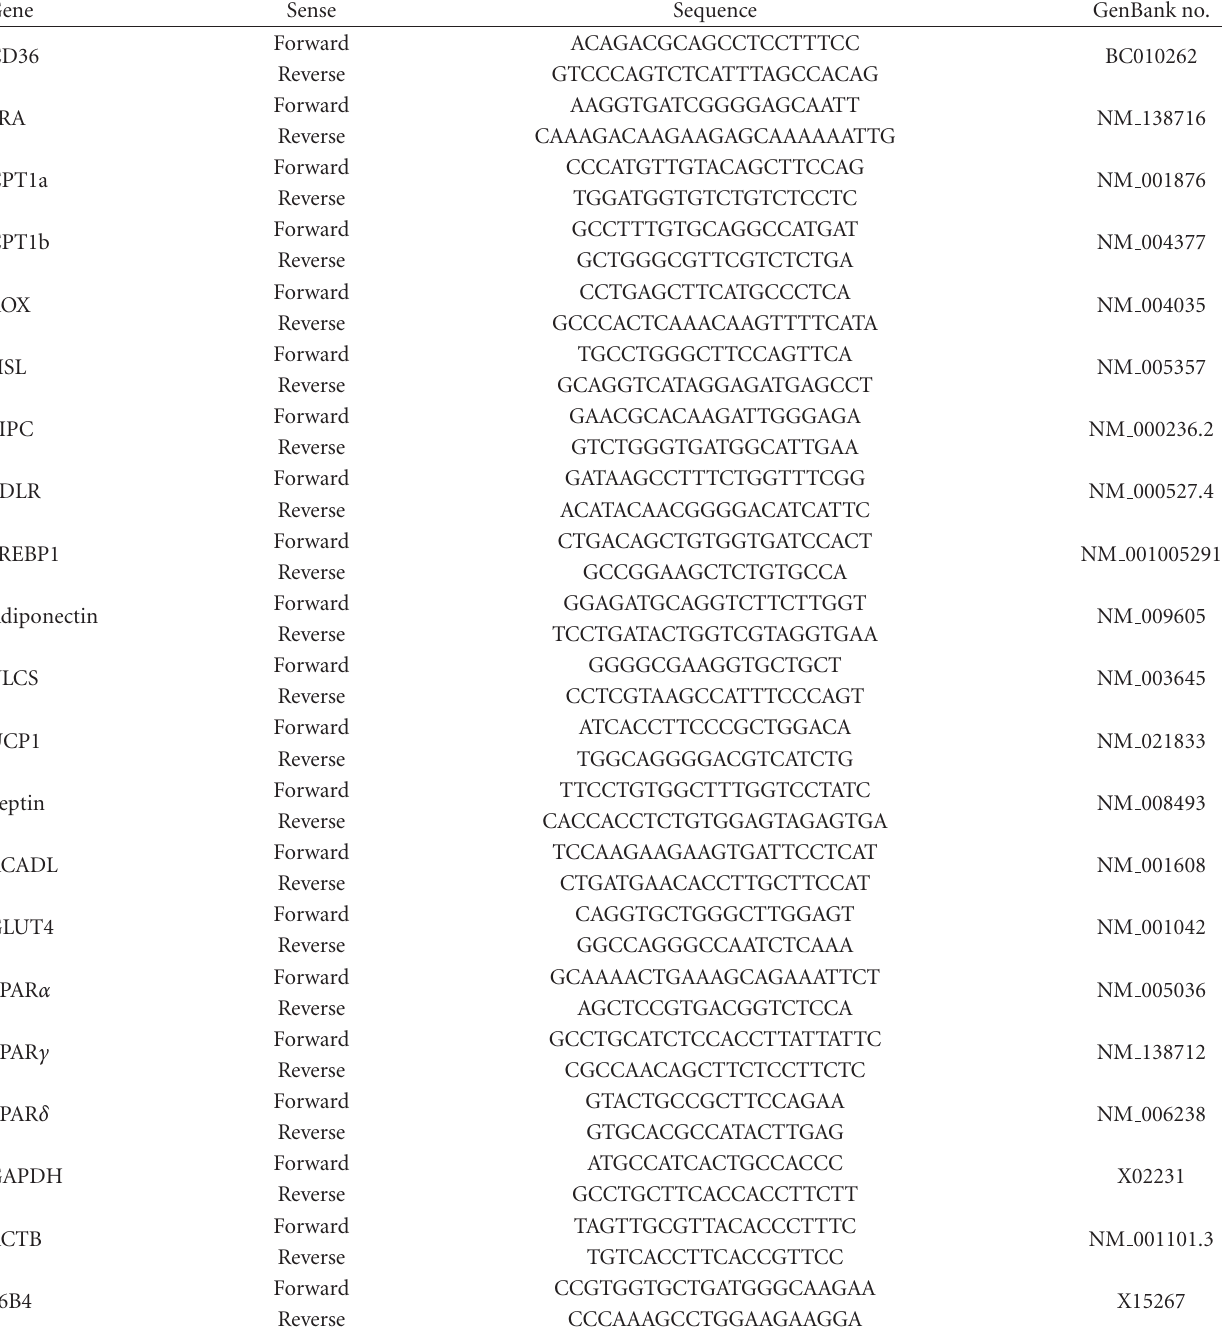
Table 1: Primer sequences used in the RT-PCR